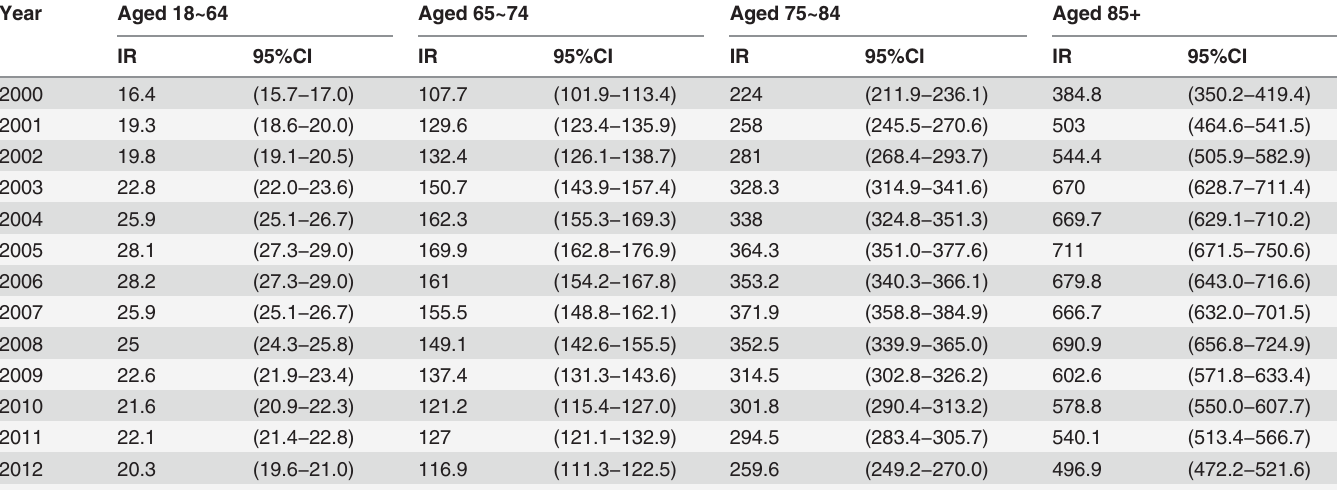
Table 2. The secular trend in the OHCA incidence rate in Taiwan (the number of cases per 100,000 persons), for national data of Taiwan from 2000 to 2012, by